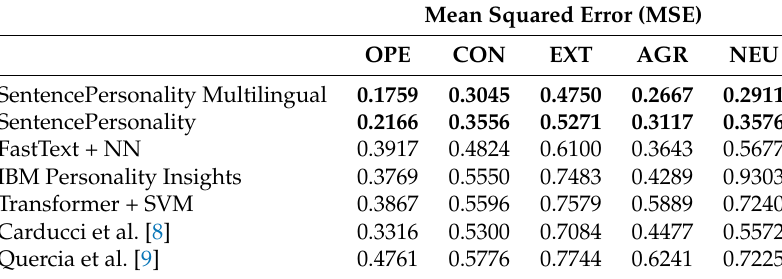
Table 3. Mean Squared Error computed averaging results over a 10-fold cross-validation using myPersonality small as dataset. The highlighted results are the lowest and the best. OPE = Openness; CON = Conscientiousness; EXT = Extraversion; AGR = Agreeableness; NEU = Neuroticism. The lower is the MSE (Mean Squared Error), the better is the result. In the case of IBM Personality Insights, when we queried their API, giving as input the raw text from myPersonality small line by line, the answer was that there was not enough text to perform the prediction. Then, we decided to submit the query grouping social media posts of the same user in a single block of text. The scores shown in the table below receive the malus of a user-wise computation instead of post-wise one. SentencePersonality is the name of our model.